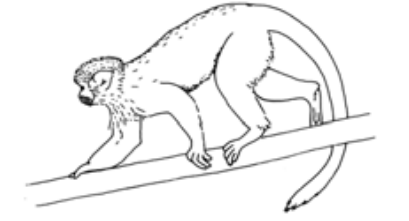
Box 3: Locomotor characteristics of common squirrel